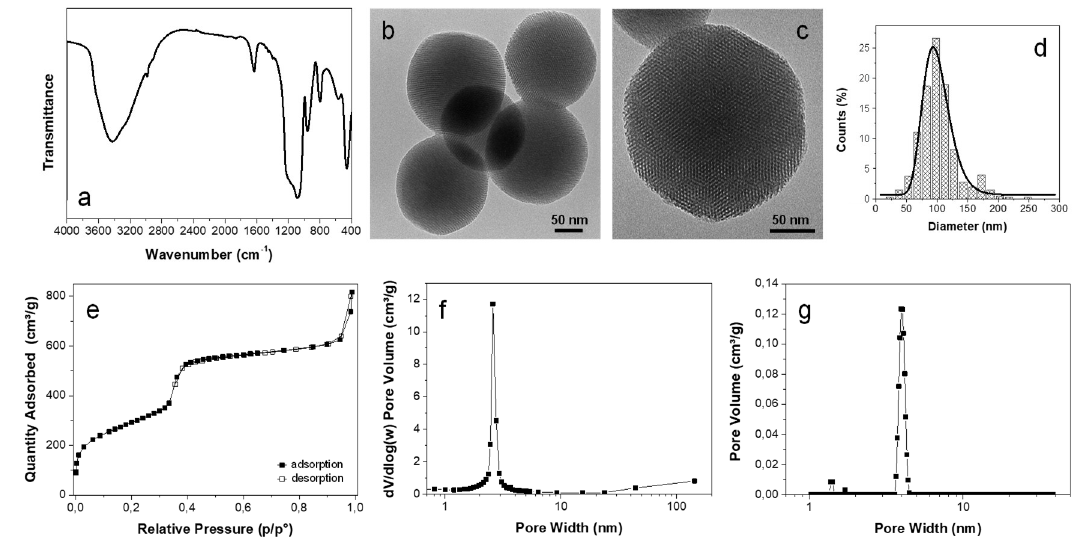
Figure 1. MSN FTIR spectrum ( a ) TEM images ( b , c ), particle size distribution ( d ), nitrogen adsorption isotherm ( e ), and pore size distribution by BJH ( f ) and NLDFT ( g ) models.